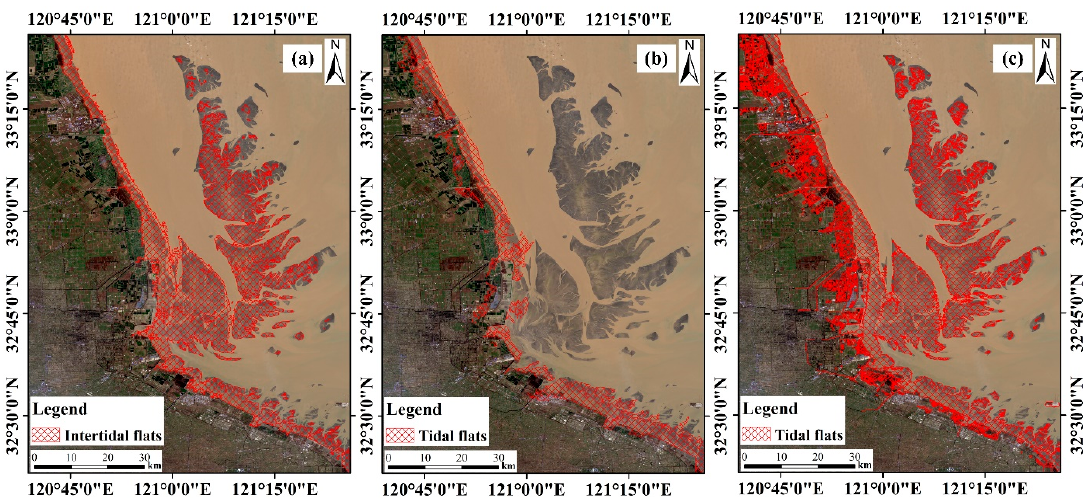
Figure 12. Detection of radial sand ridges (RSR) in Jiangsu Province within ( a ) our map, ( b ) LUCC 2015 and ( c ) Murray’s, respectively. The base map from Landsat OLI acquired on 1 January 2016 is displayed in true color.